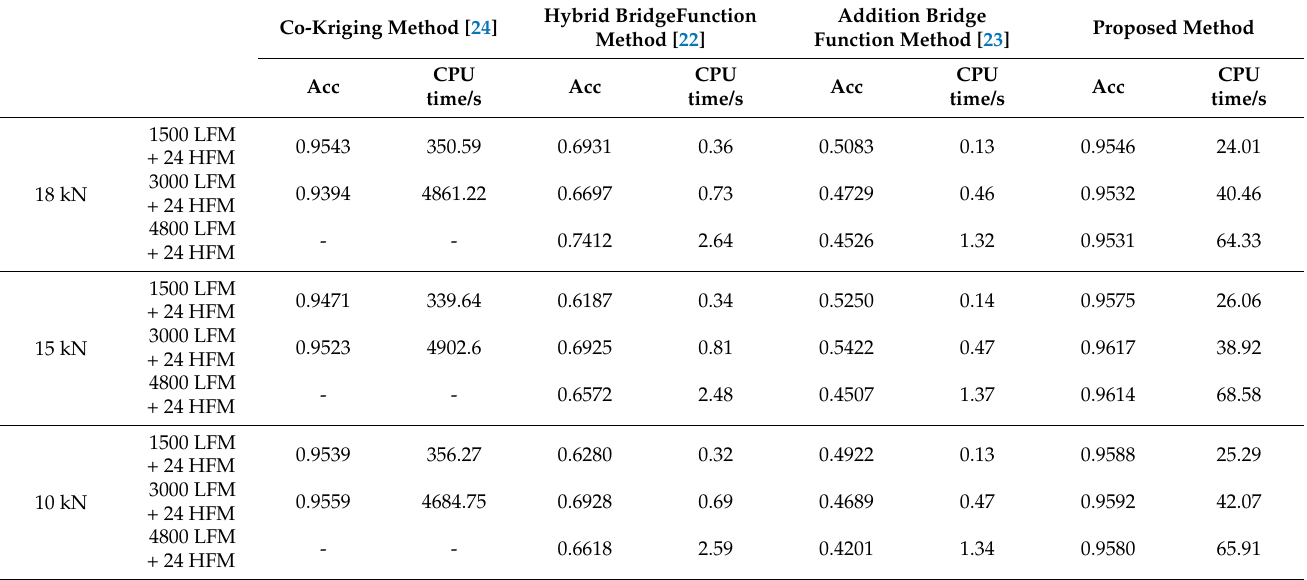
Table 3. The prediction accuracy and computational cost of the various data fusion models for the hierarchical stiffened